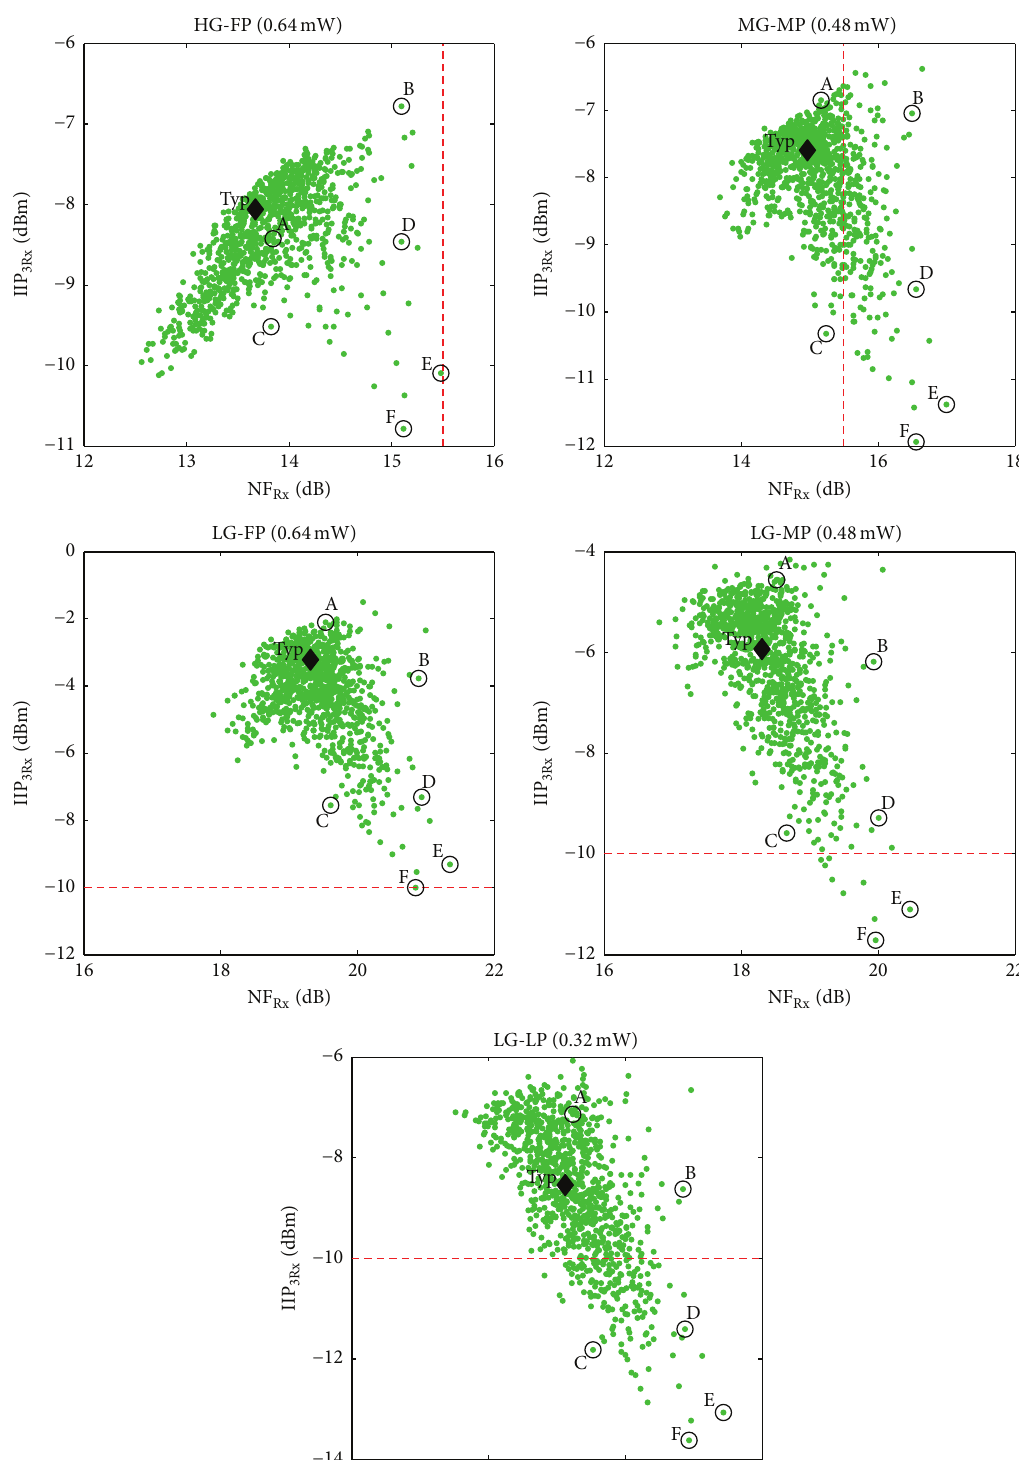
Figure 3: NF and IIP 3 of the receiver calculated from Monte Carlo simulation results of the designed